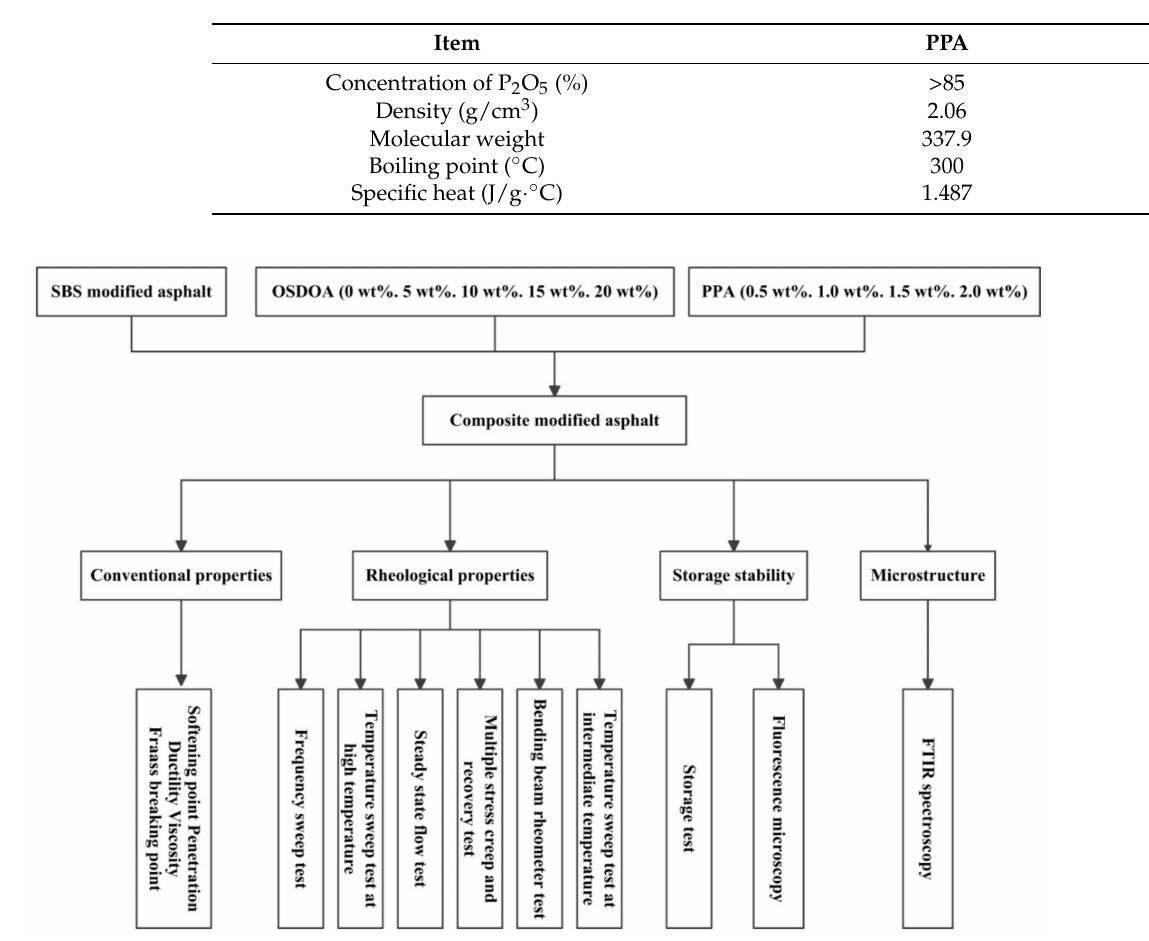
Figure 1. Technical roadmap of this